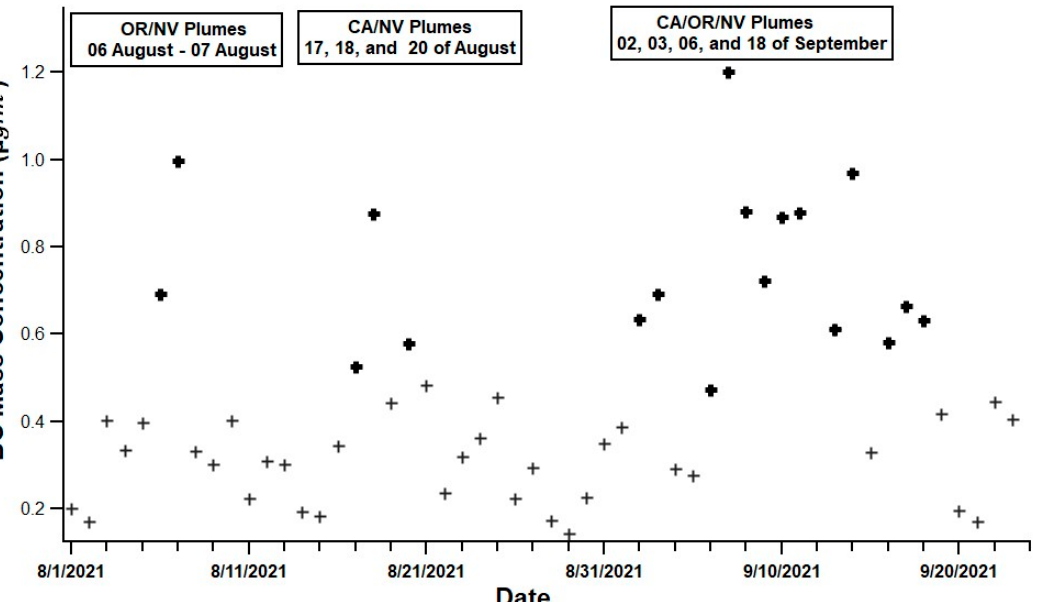
Figure 7. Equivalent Black Carbon mass concentration measured in micrograms per cubic me- ter. The bold marking represents those eighteen event days when the wildfire plumes reached our